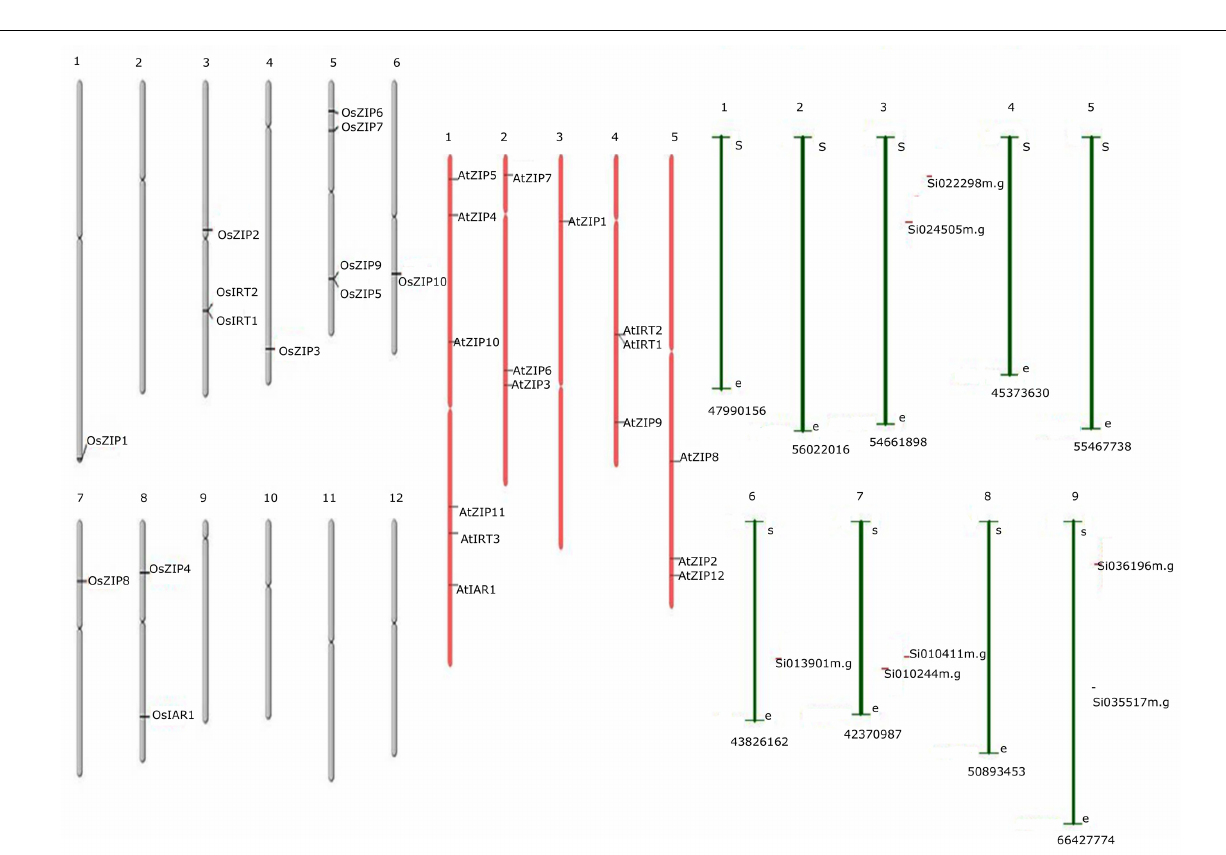
FIGURE 2 | The distribution of ZIPs across the length of the chromosome, along with its name is mentioned on the right side of every chromosomal segment. There were a total of 36 genes, 16 from Arabidopsis, 13 from rice and 7 from foxtail millet. Gray color chromosomes indicates rice, whereas pink and green for Arabidopsis and foxtail millet,